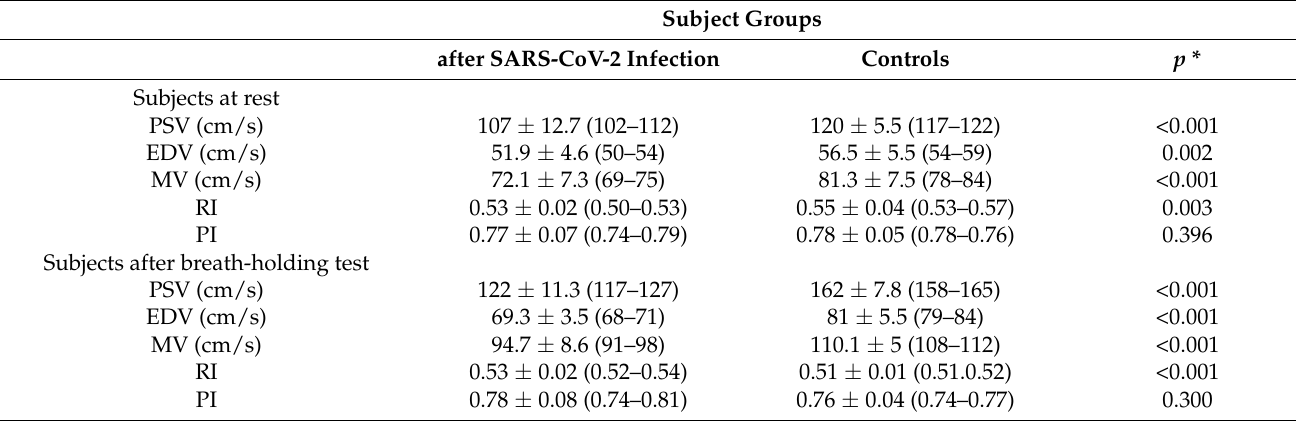
Table 3. Representation of arithmetic means of flow velocities through middle cerebral artery and standard deviations ( ± SD) (95% CI) of these